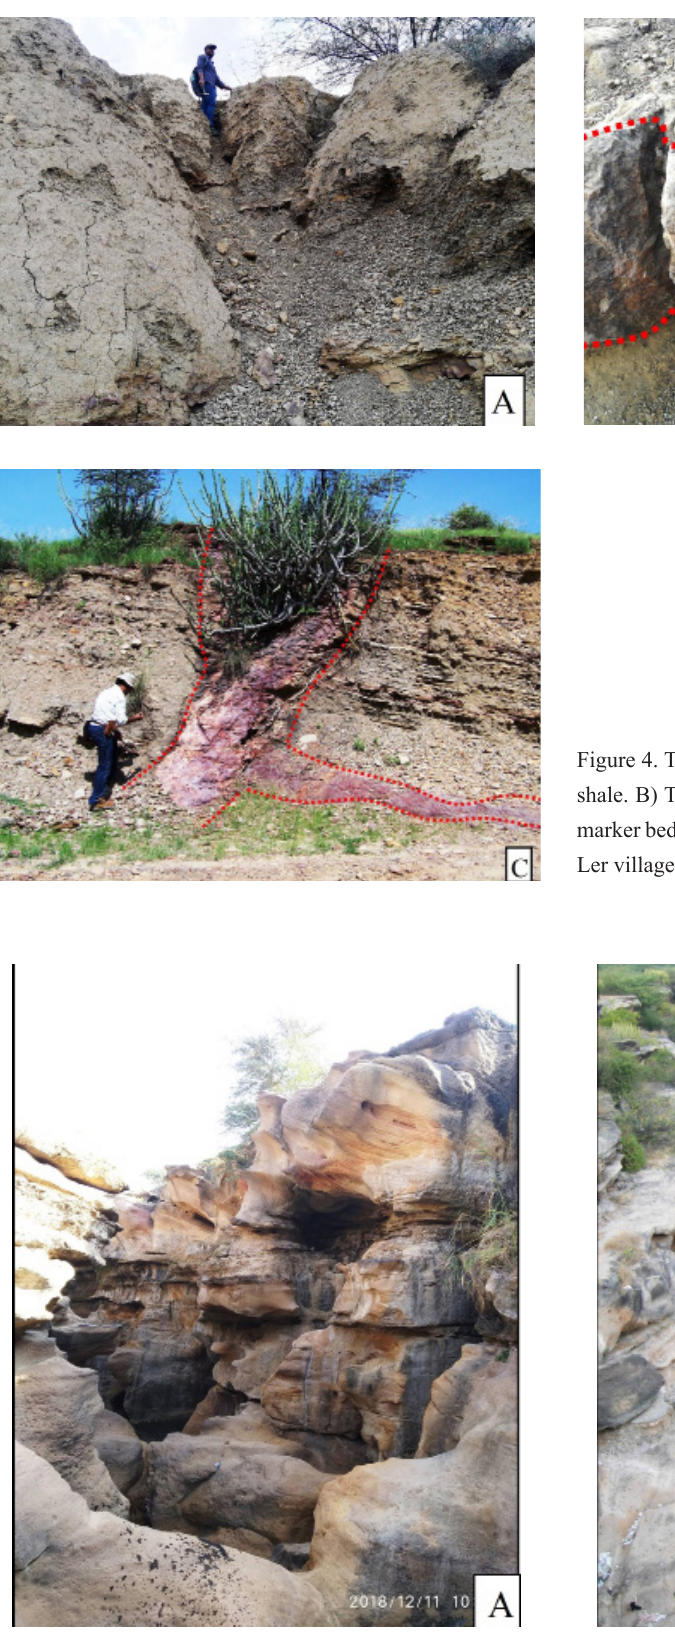
Figure 5. Deep gorge of the Khari River. A) Photo taken within the gorge, B) photo taken from the Khari